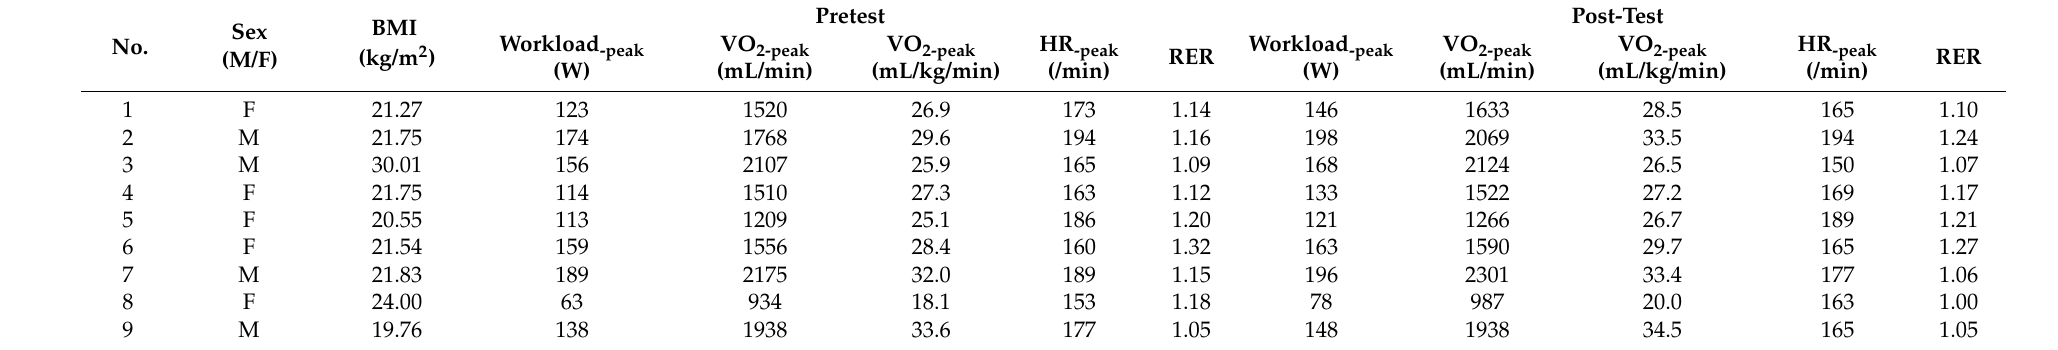
Table 1. Basic information and data of cardiopulmonary exercise test of participants.